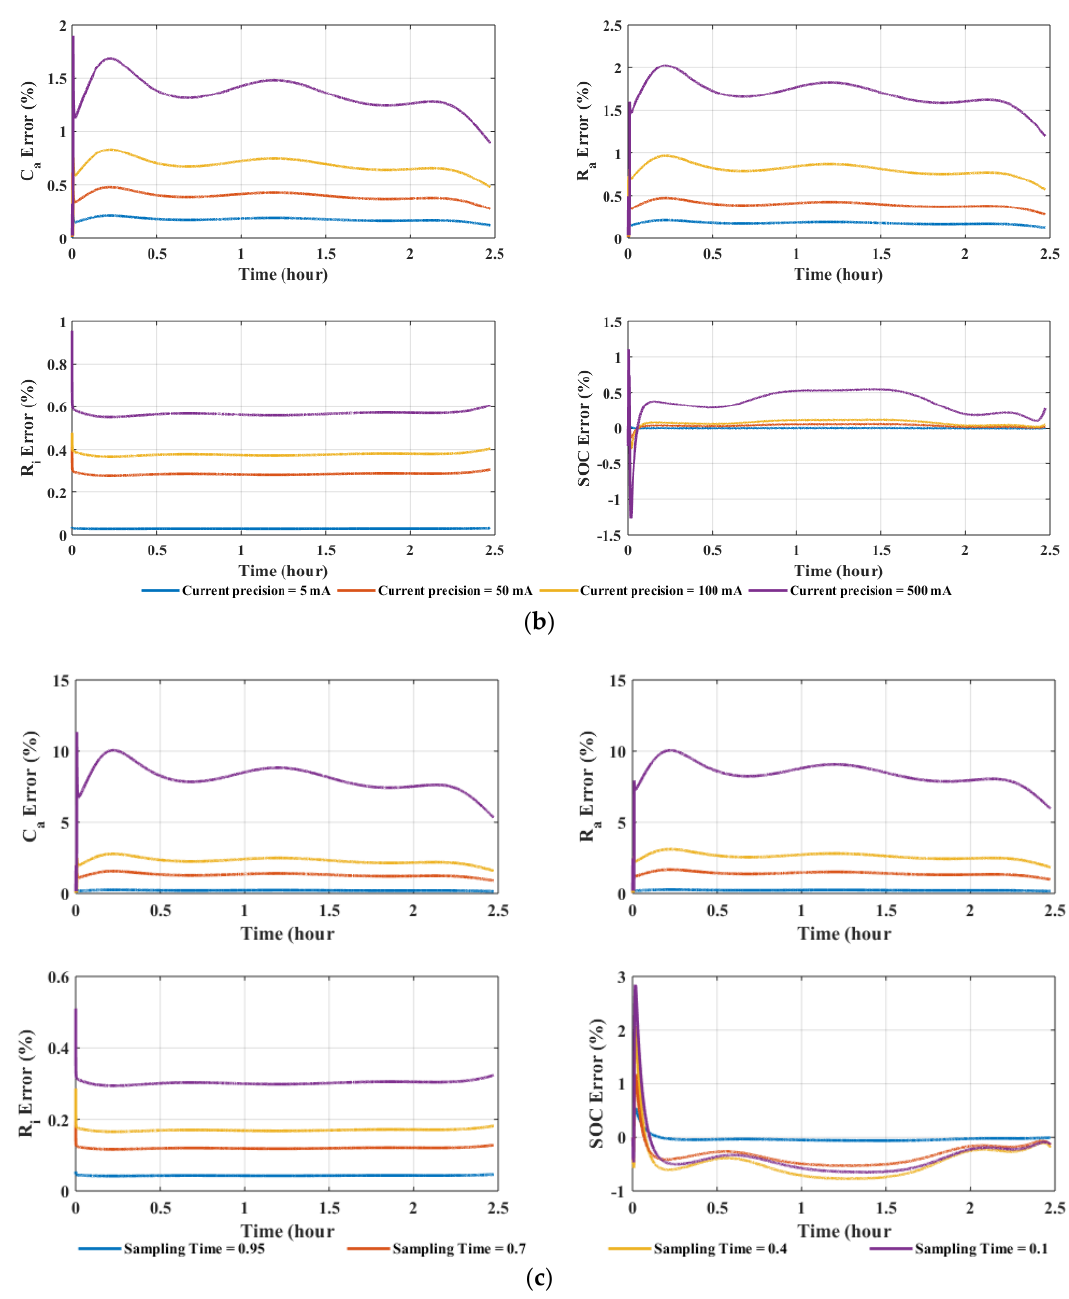
Figure 11. Parameters and SOC estimation error results: ( a ) at different voltage sensor accuracy; ( b ) at different current sensor accuracy; ( c ) at different sample time.